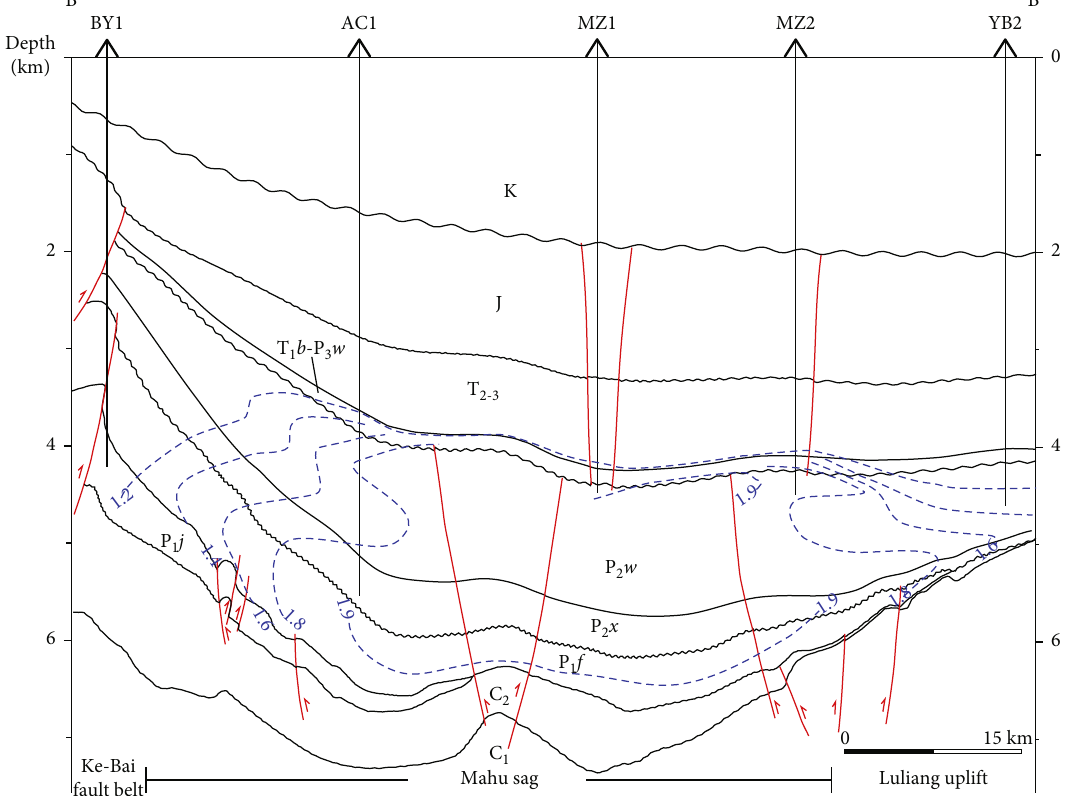
Figure 4: Pressure coe ffi cient section in the Mahu sag (see section location in Figure